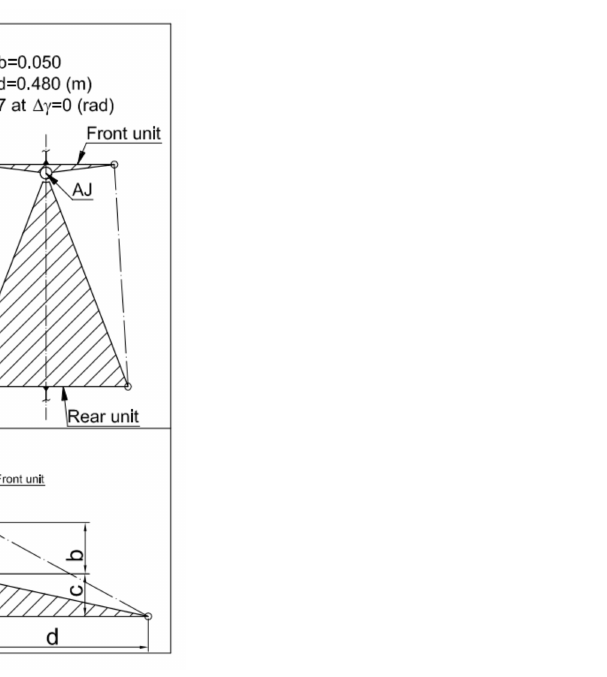
Figure 13. Configurations of the hydraulic steering geometry used in the simulation calculations.